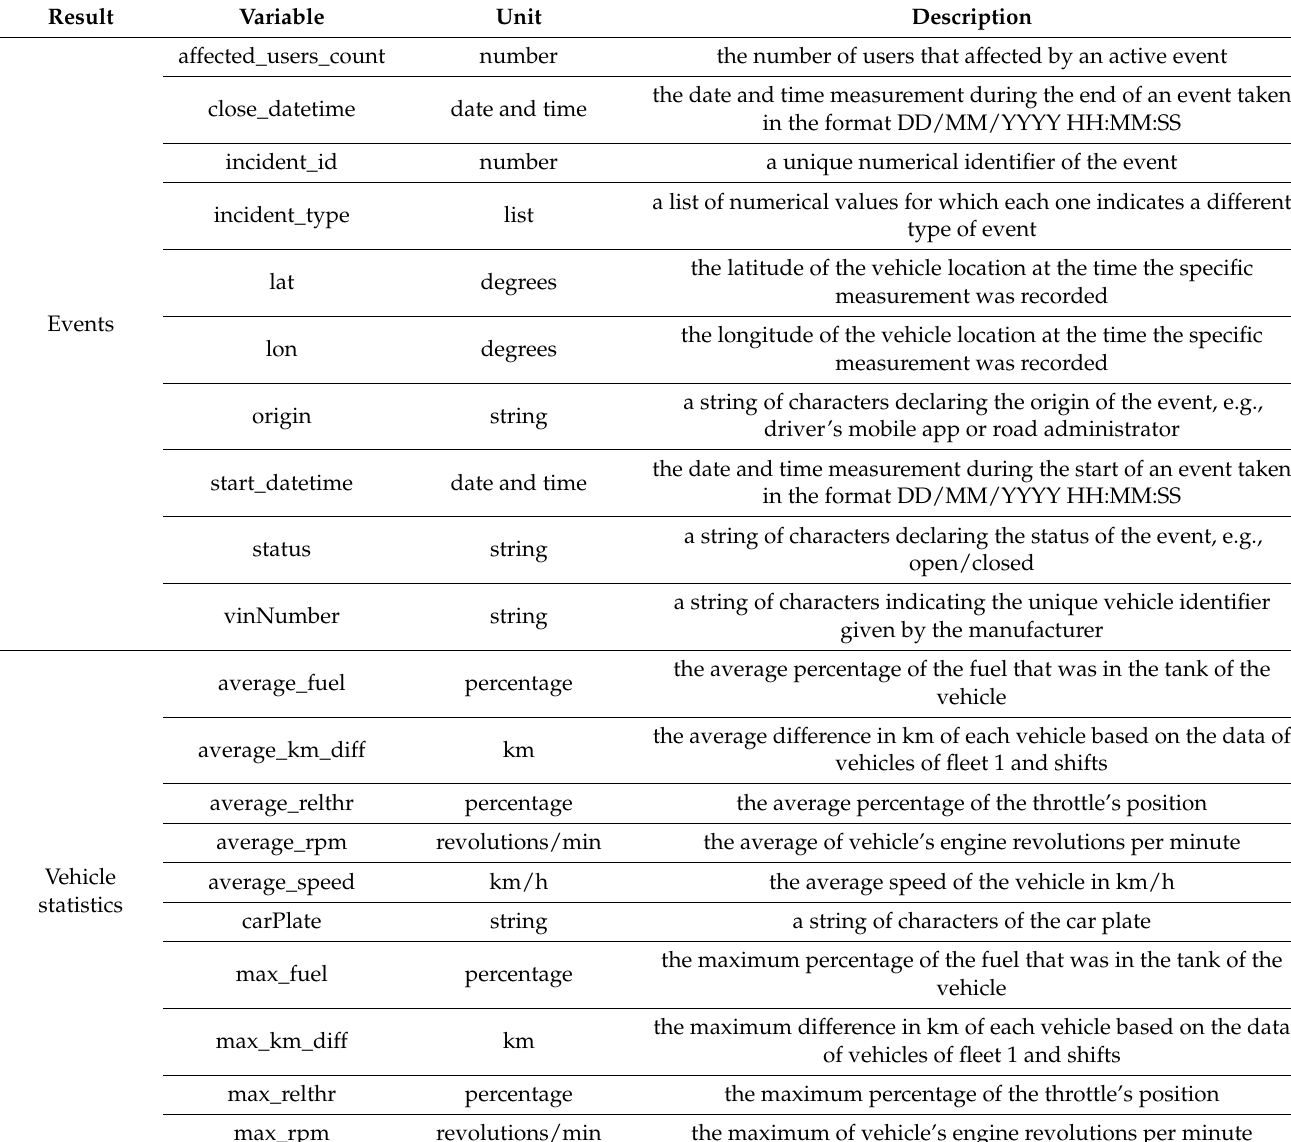
Table 2. The different data formats provided by the DBDA platform based on the analysis